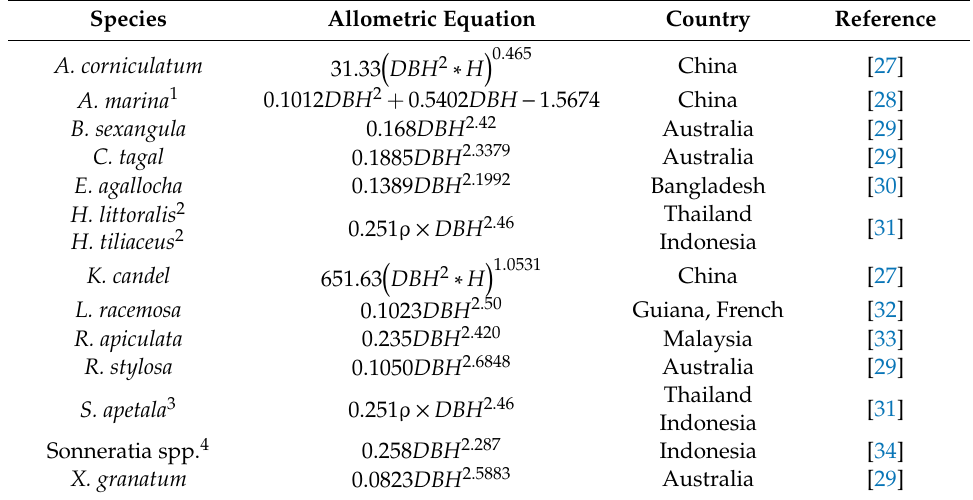
Table 1. Summary of the species-specific aboveground biomass allometric equations used in this study. The units of AGB, DBH, and H are kg, cm, and m,